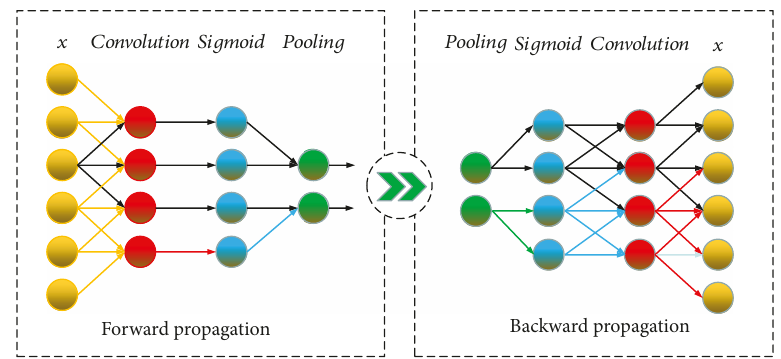
Figure 9: The schematic map of network training about CNN.